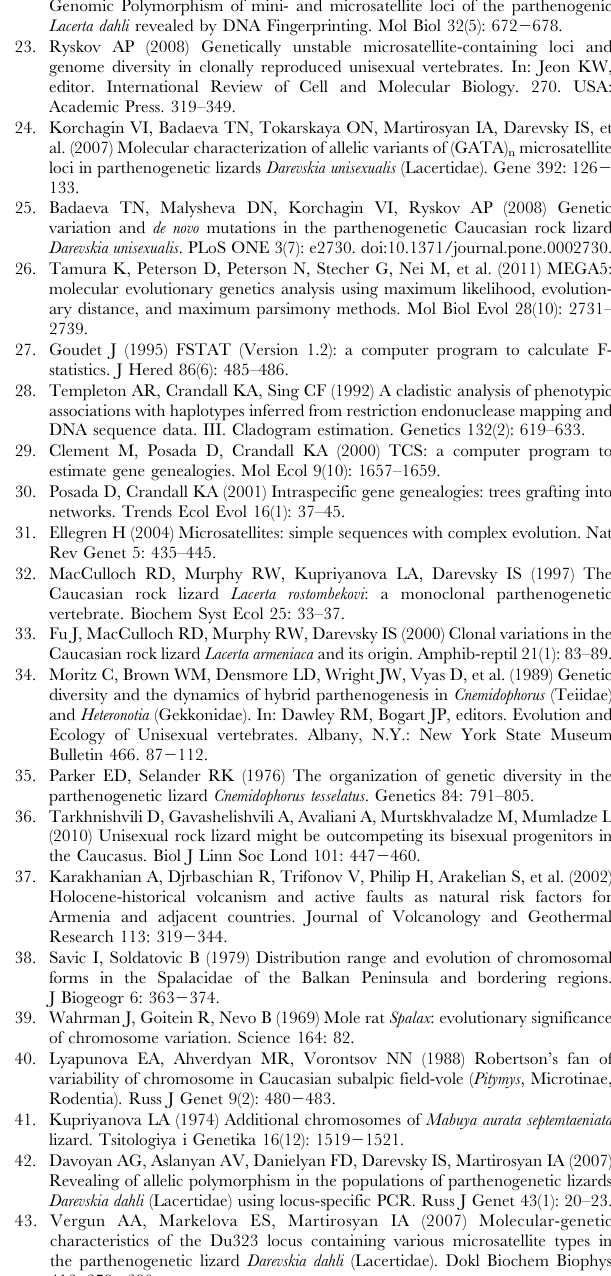
Table S1 Polymorphisms of three microsatellite loci Du215, Du281, and Du323 for nine genotypes in D. dahli (see Figure 2). GATA repeat is designated by the letter A.